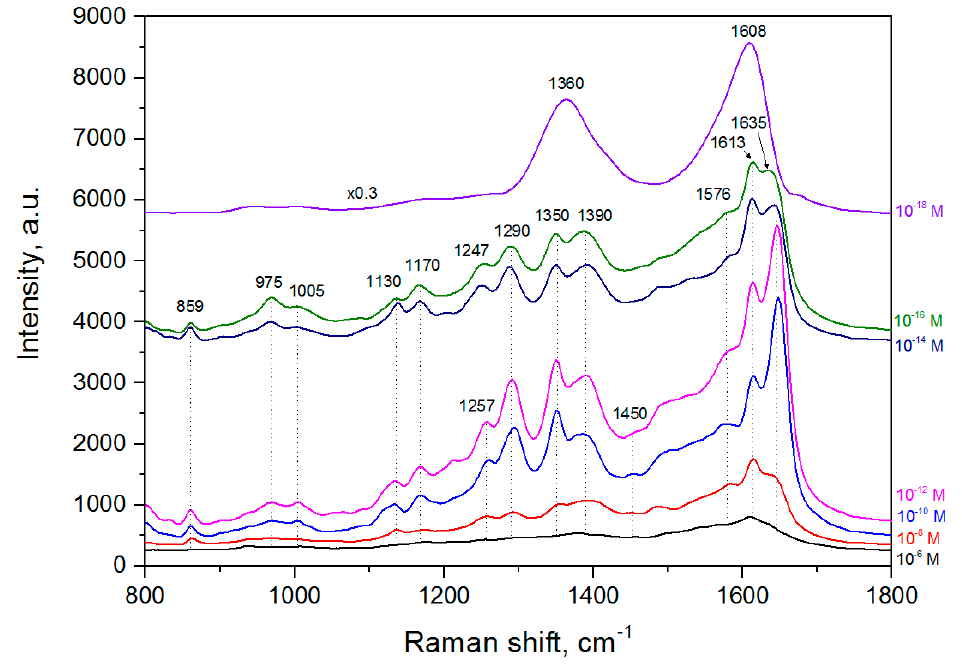
Figure 7. SERS spectra of the lactoferrin molecules adsorbed on the silvered por -Si.